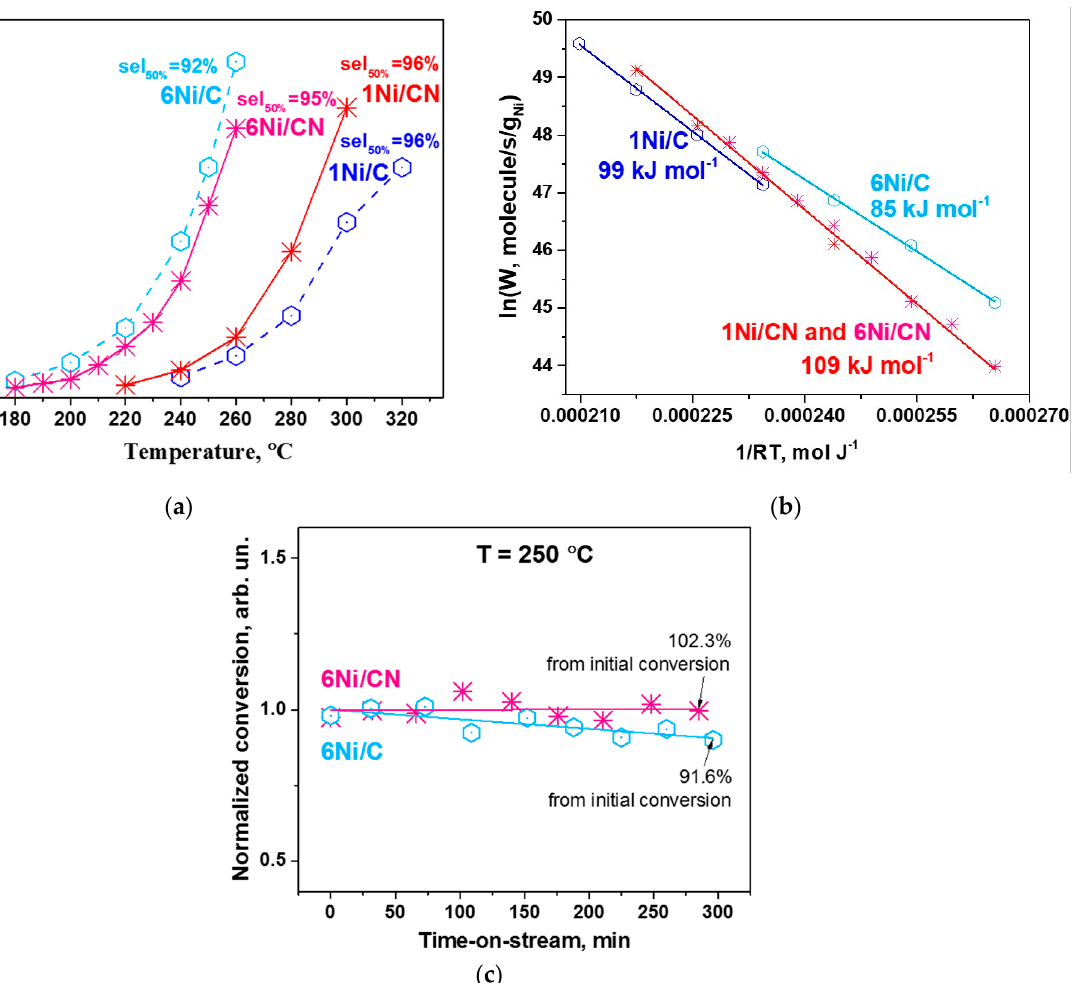
Figure 6. ( a ) Conversion-temperature dependences and ( b ) Ni mass-based Arrhenius plots for 1Ni/C, 1Ni/CN, 6Ni/C and 6Ni/CN (7 mg each). The selectivity to H 2 at 50% of formic acid conversion of each catalyst is shown in ( a ), the apparent activation energy with an error of ± 2 kJ mol − 1 is indicated in ( b ). ( c ) Stability of 6Ni/C (3.1 mg) and 6Ni/CN (3.3 mg) in the reaction at 250 °C during 5 h tests. The ratio of the final to the initial conversion is indicated.